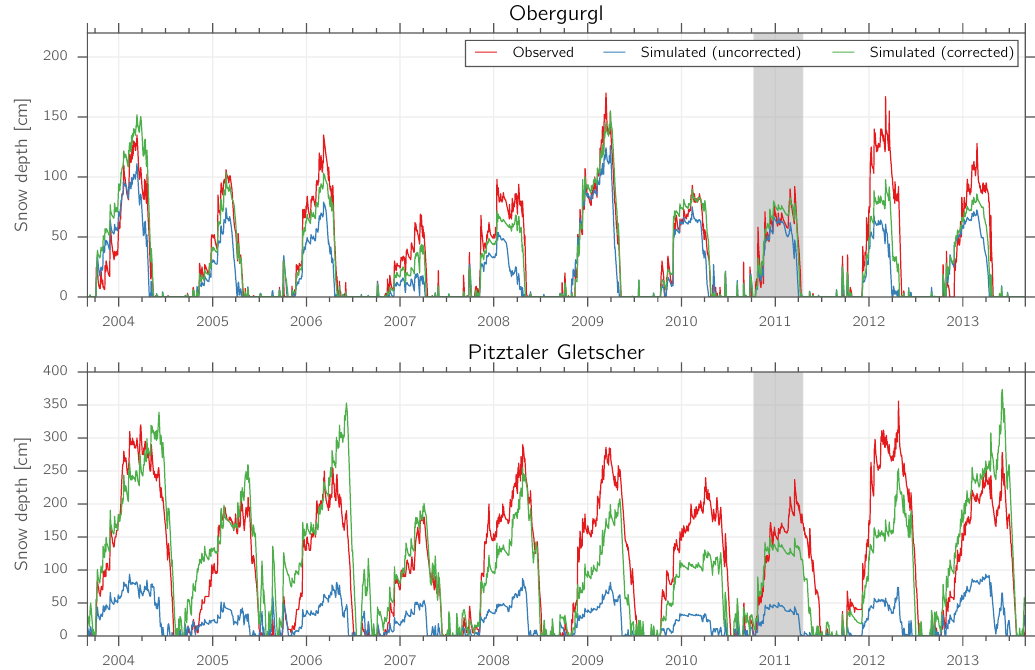
Figure 6. Observed and simulated (using uncorrected and corrected precipitation, respectively) snow depth for stations Obergurgl (1942ma.s.l.) and Pitztaler Gletscher (2864ma.s.l.). The gray shaded area corresponds to the period in between the two ALS surveys. Table 5. Mean annual areal precipitation for the gauged catchments in the study area as calculated by closing the water balance (OEZ method) and AMUNDSEN (using uncorrected and corrected precipitation, respectively) for the period